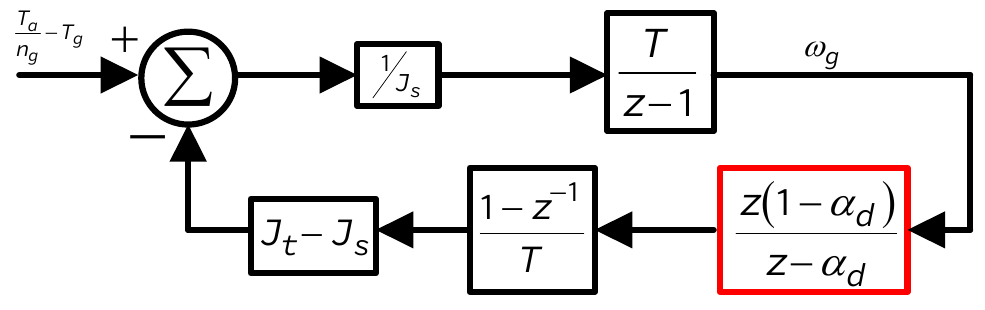
Figure 8. WTS with first-order filter